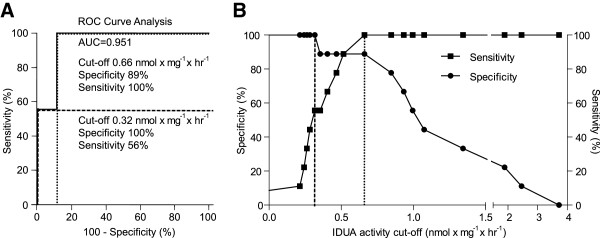
ROC curve analysis. (A) ROC curve of IDUA activity for discrimination between MPS I-H and non MPS I-H. (B) Sensitivity and specificity for IDUA activity cut-off levels to discriminate between MPS I-H and non MPS I-H. Dashed lines represent chosen cut-off levels of 0.32 and 0.66 nmol × mg-1 × hr-1 IDUA activity.